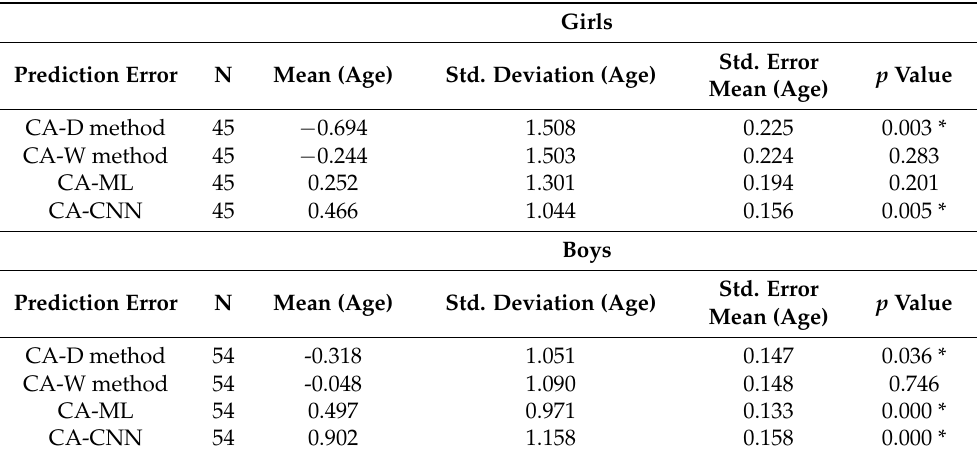
Table 2. The performance of studied methods in predicting CA of GD children.